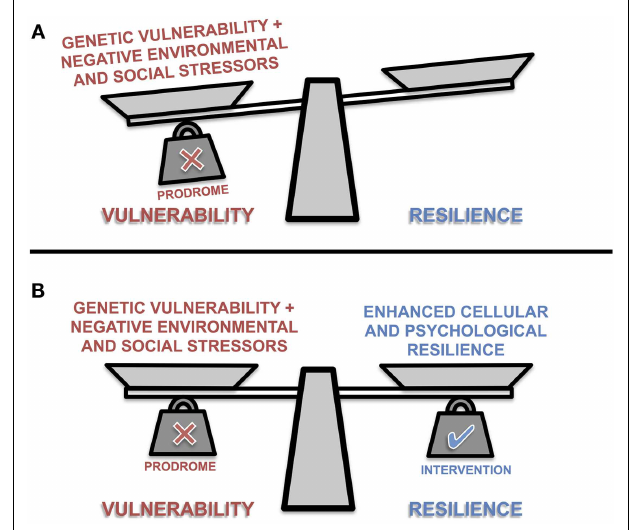
FIGURE 1 |A representation of the conceptual balance between vulnerability and resilience in prodromal individuals .The scale’s balance beam teeters between vulnerability and resilience as scale pans are loaded with different positive and negative biological, psychological and social factors.The presence or absence of these factors influence the ability of the individual to cope with stressors, and maintain allostasis. (A) Prodromal individuals are somewhat predisposed to vulnerability; but with intervention (B) an individual may adopt more adaptive environmental coping strategies, support mechanisms, general healthy lifestyle choices, and/or receive pharmacological interventions that collectively enhance physiological and psychological